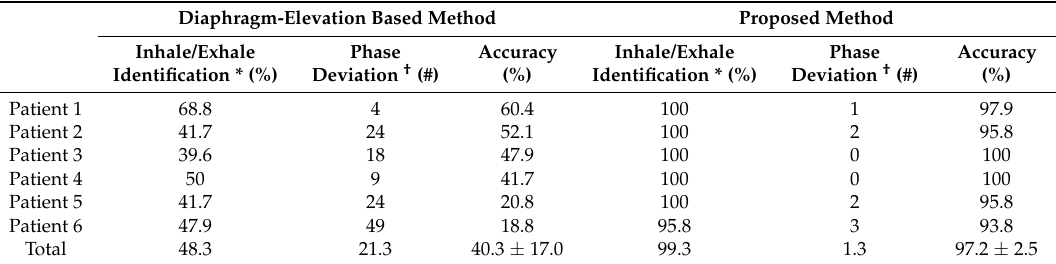
Table 1. The respiratory phase identification performance of the proposed method compared with the previous diaphragm elevation-based method in terms of the inhale/exhale identification, phase deviation, and